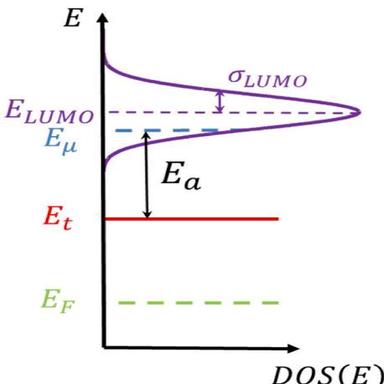
Representation of the Gaussian DOS for the mobile carriers (here electrons), figuring the transport energy level Eμ, a discrete trap level Et, and the Fermi energy level EF during the relaxation of traps.